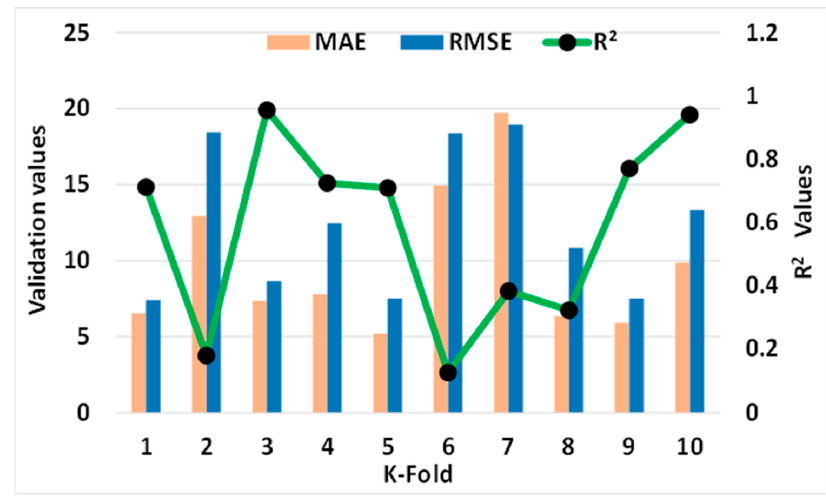
Figure 20. Statistical analysis of BR model.